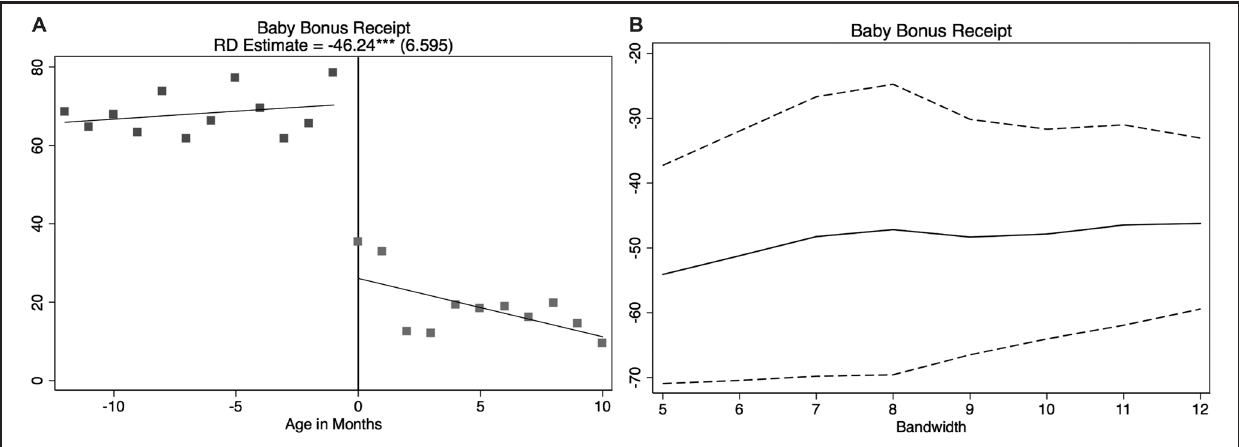
The percentage of mothers receiving the Baby Bonus. (A) Each data point corresponds to the average value of the percentage of mothers receiving the Baby Bonus by month of birth of the child in 1-month bins. The window includes all children born to mothers from January 2010 until November 2011.The vertical line denotes the PPL cutoff of January 1 2011, normalized to 0. (B) The equivalent coefficient estimates and associated 95% confidence intervals when equation 1 is estimated using 3, 4, ..., 12 month-of-birth cohorts on either side of the